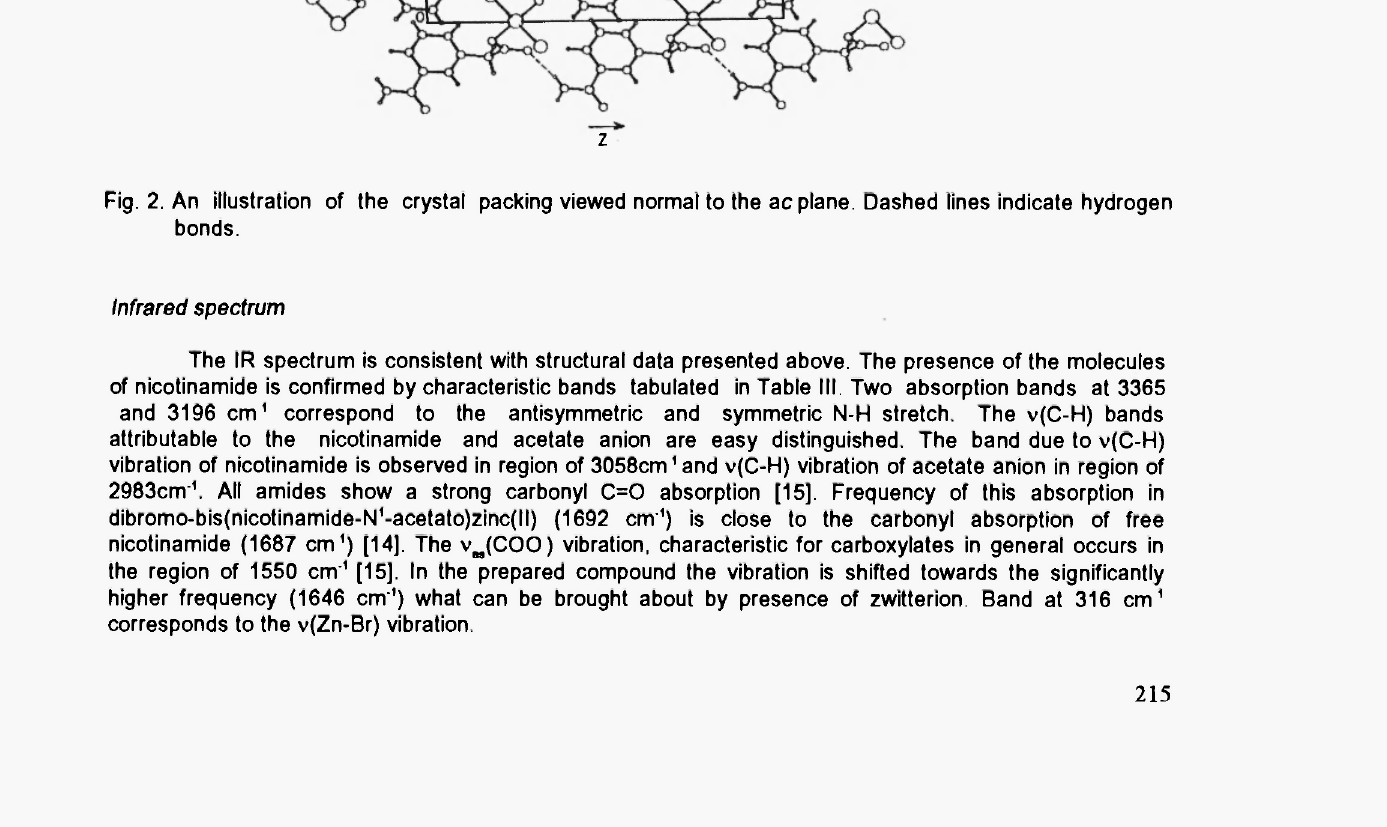
Fig. 2. An illustration of the crystal packing viewed normal to the ac plane. Dashed lines indicate hydrogen